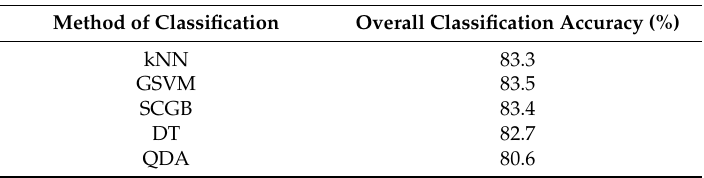
Table 5. Overall accuracies of NDVI based land cover classification.